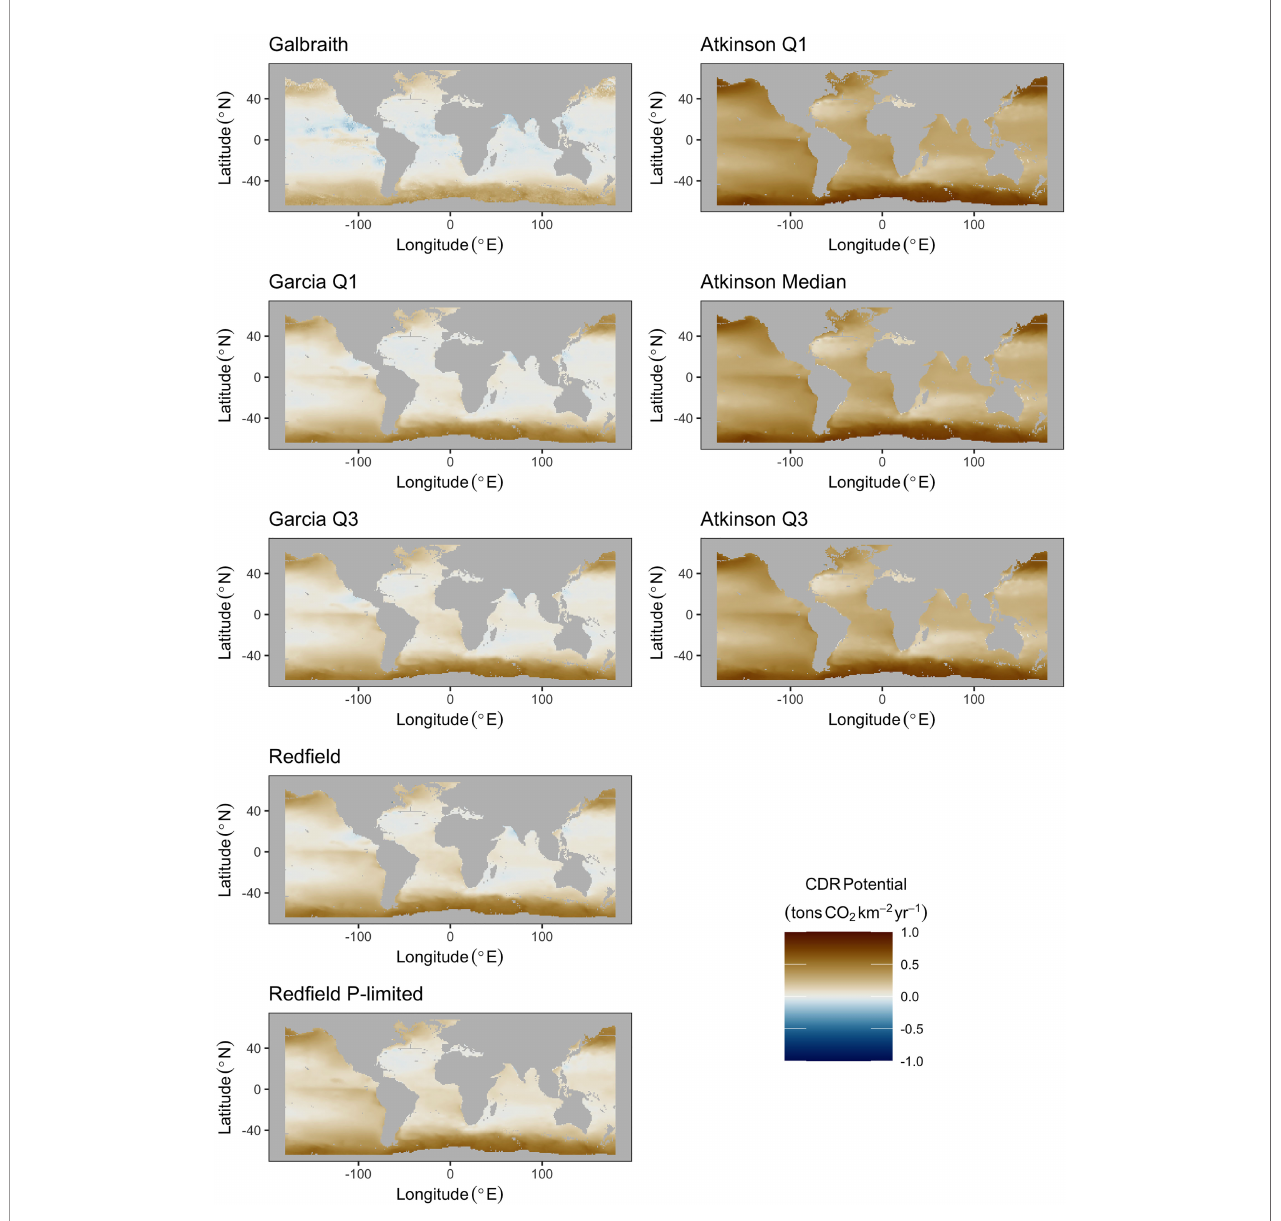
FIGURE 2 | Maps of maximum potential carbon dioxide removal for all microalgae (left column) and macroalgae (right column) stoichiometries under the constraint of an upwelling pipe no longer than 500